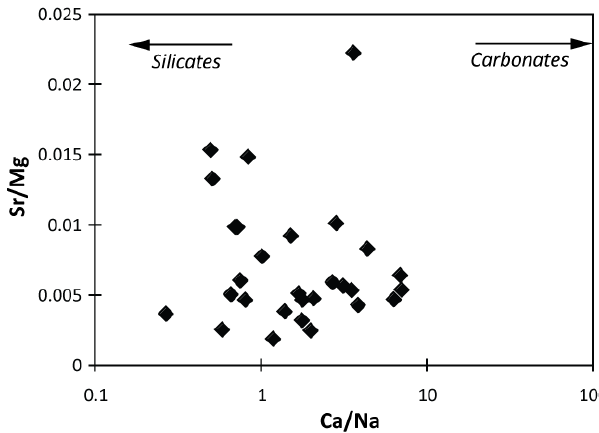
Figure 1. Mg/Sr and Ca/Na from the Earth’s major rivers (Gail- lardet et al., 1999), showing that Mg/Sr does not vary between car- bonate (high Ca/Na) and silicate (low Ca/Na) weathering, allow- ing use of riverine Sr fluxes (Lear et al., 2003) to calculate river Mg fluxes. Rivers with high Mg/Sr (Rhone, Huanghe, Wisla, Rhine) plausibly have anthropogenic